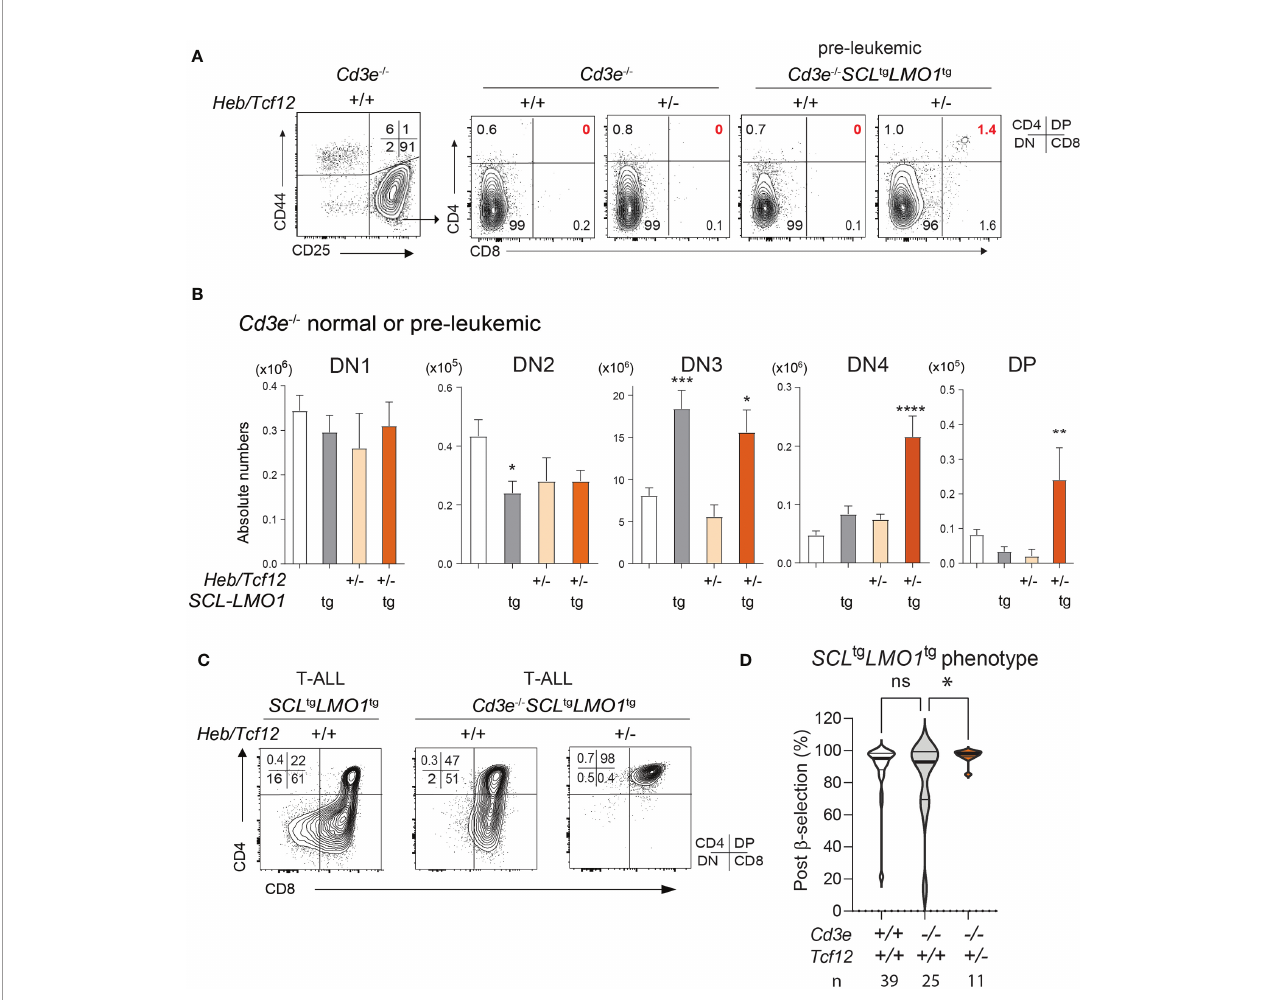
FIGURE 4 | The SCL and LMO1 oncogenes favor the DN-DP transition at the leukemic stage despite the absence of pre-TCR/CD3 signaling: synergy with decreased Heb gene dosage. (A) FACS phenotypes of normal Cd3e -/- or pre-leukemic Cd3e -/- SCL tg LMO1 tg thymocytes from Heb/Tcf12 +/+ and Heb/Tcf12 +/- backgrounds. Flow cytometry pro fi les for the CD4 − CD8 − DN populations are shown in Figure S4 . (B) Absolute numbers of thymocytes within the indicated subsets in normal Cd3e -/- or pre-leukemic Cd3e -/- SCL tg LMO1 tg in Heb/Tcf12 +/+ and Heb/Tcf12 +/- backgrounds. Shown are the average ± SD of at least 5 mice per group, taken at 4 weeks. Note the signi fi cant increase in the post- b selection DN4 and DP populations in SCL tg LMO1 tg Heb/Tcf12 +/- mice. (C) FACS phenotypes of Cd3e -pro fi cient or de fi cient SCL tg LMO1 tg leukemias from Heb/Tcf12 +/+ and Heb/Tcf12 +/- backgrounds. (D) T-ALL with a post- b -selection phenotype. Shown are the percentages of cells from each T-ALL with post- b -selection surface phenotypes (DN3-4, DN4, ISP, SP). n represents the numbers of mice analysed. * adj p=0.02. pvalue < 0.05; **p value < 0.005; ***p value < 0.0005; ****p value < 0.0001, ns, Non signi fi